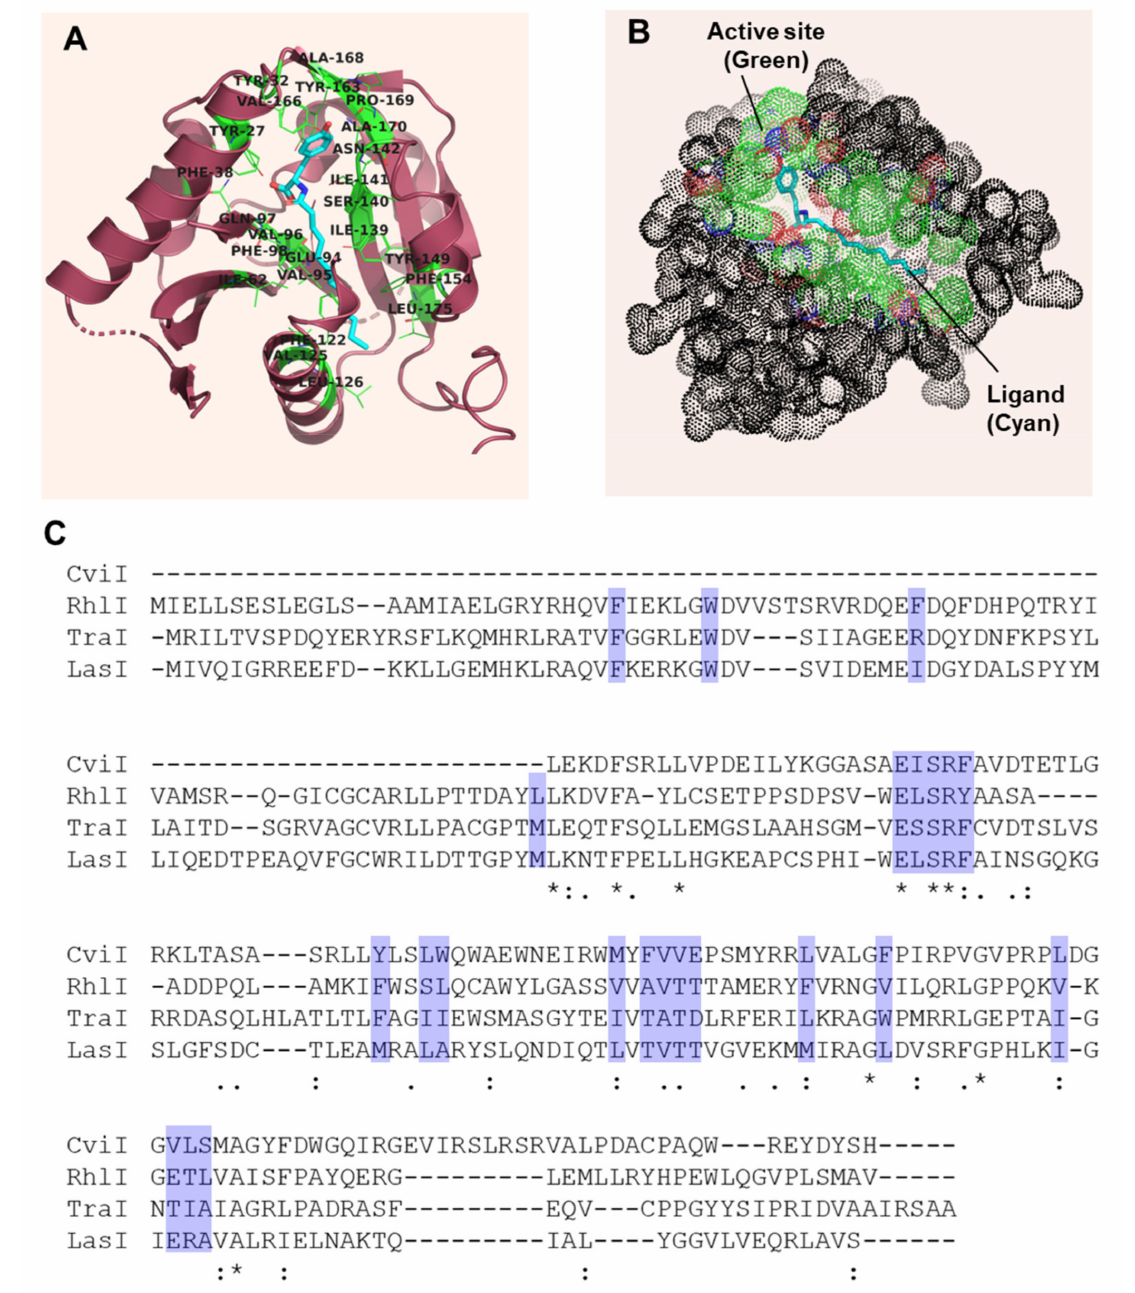
Figure 3. ( A ). Structural and sequence analysis of FeeM and AHL synthase proteins. Detailed analysis the ligand-binding pocket of N-acyl amino acid synthase (FeeM) PDB-ID:2G0B. (B). The dot representation of the protein with the ligand-binding site is highlighted in green with the ligand molecule (N-dodecanoyl-L-tyrosine) ( C ). Multiple-sequence alignments of the amino acid sequence of AHL synthase proteins (CviI, RhlI, TraI, and LasI) with highlighted regions (blue) correspond to the ligand-binding pockets of the